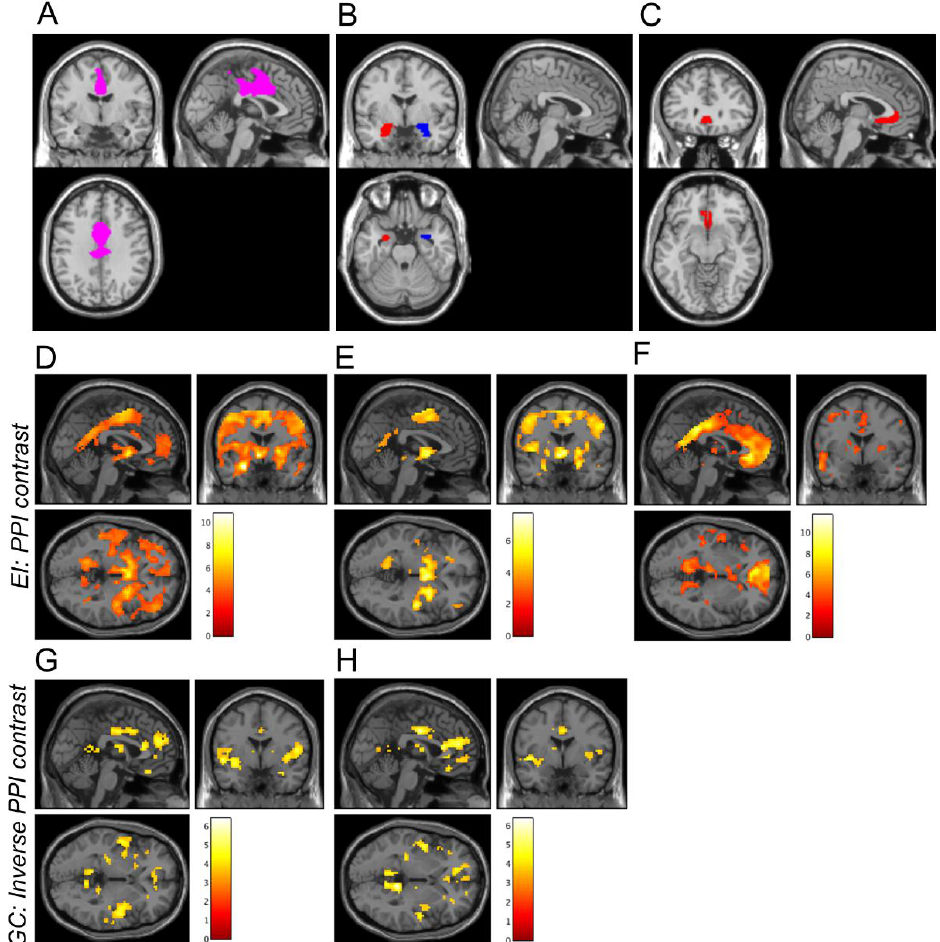
Figure 1. A priori ROIs and whole-brain PPI connectivity averaged across all runs and scan days. Figure A depicts the DMFC ROI used as a target region in the PPI analysis ( A ). Figure B,C depict the three seed regions: the left and right amygdala ( B ) and the subgenual anterior cingulate cortex ( C ). D,H depict results from seed regions showing significant PPI effects in the DMFC cortex ROI. Increases in whole-brain connectivity (positive PPI contrast) were observed during the EI task for the left amygdala ( D ), right amygdala ( E ), and subgenual anterior cingulate cortex ( F ) seeds. Decreases in whole-brain PPI connectivity (negative PPI contrast) were observed during the GC task for the left amygdala ( G ) and right amygdala ( H ) seeds. For illustrative purposes only, images were thresholded at p < 0.001 (uncorrected), and the colour bars indicate t-values. The inverse PPI contrast is displayed for the GC task (G,H) because mean PPI connectivity with the DMFC ROI was significantly negative (see Figure 2).